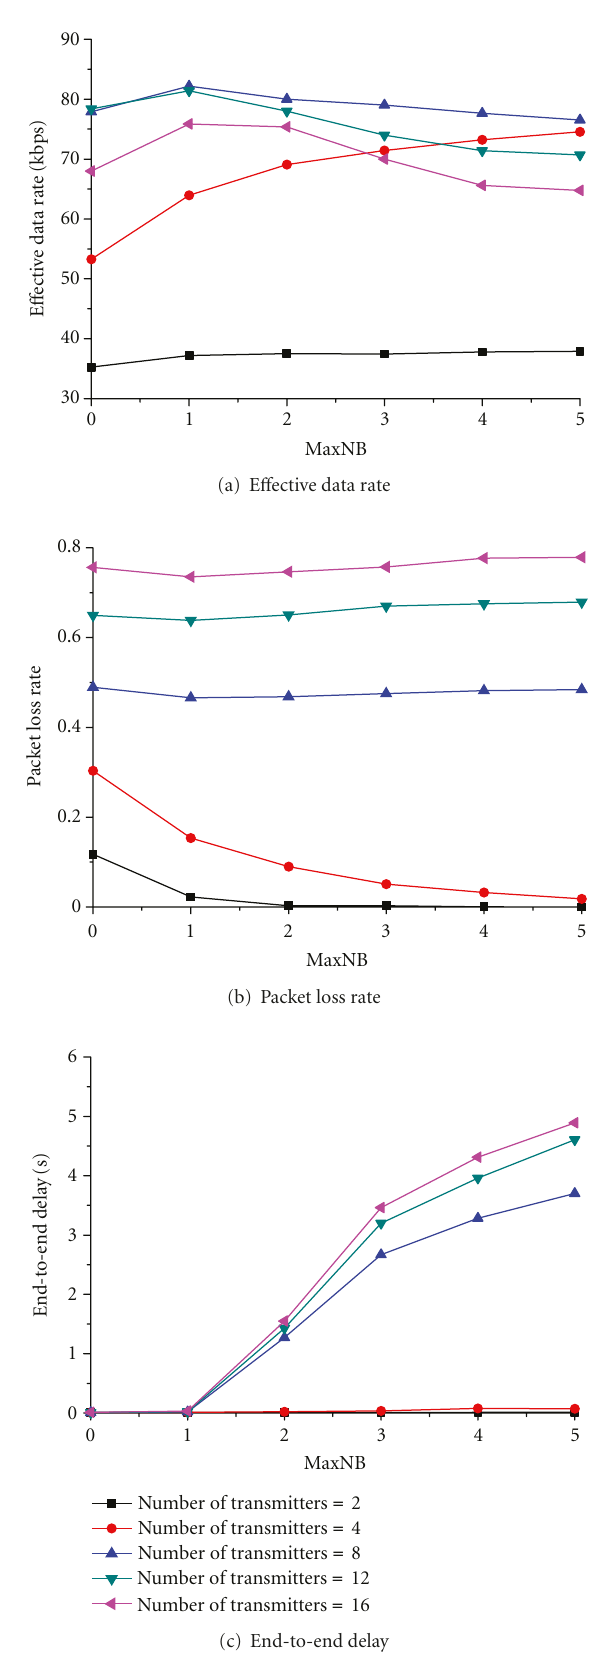
Figure 5: QoS with di ff erent MaxNB